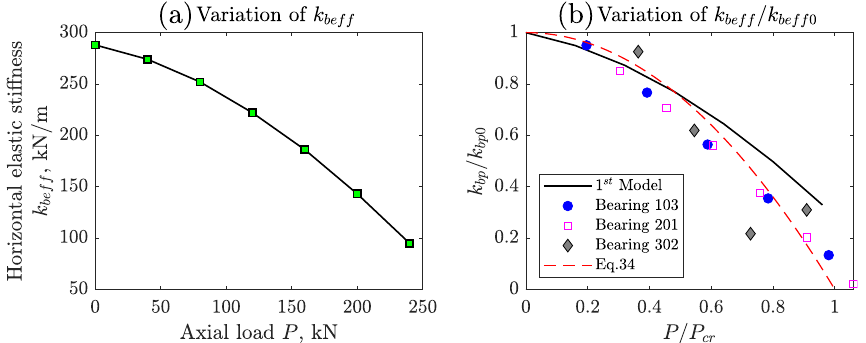
Fig. 9 Variation of horizontal effective stiffness with axial compression